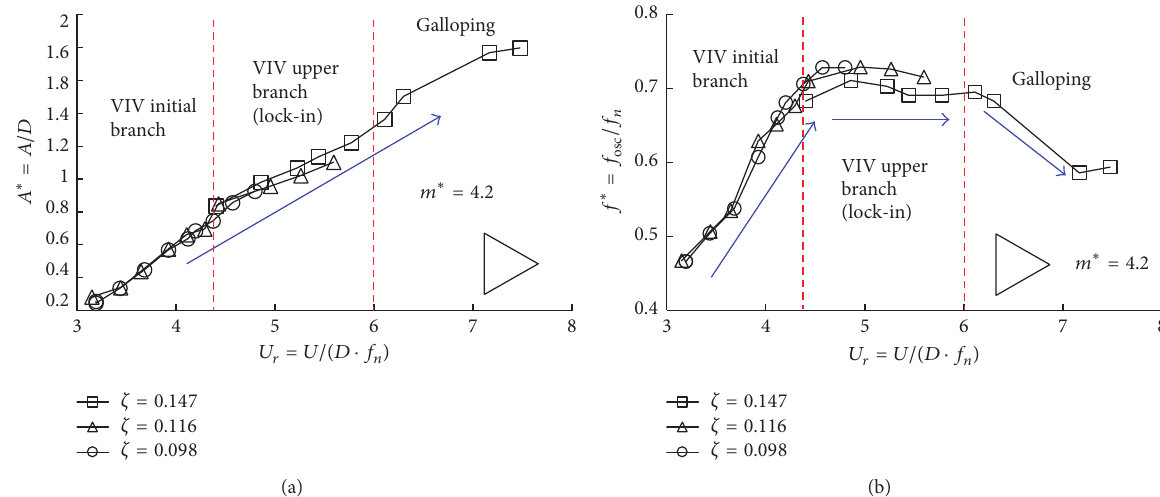
Figure 8: Variations of the amplitude ratios and the frequency ratios against the reduced velocities for regular triangle prism. Amplitude ratio 𝐴 ∗ = 𝐴/𝐷 ; frequency ratio 𝑓 ∗ = 𝑓 osc /𝑓 𝑛 ; reduced velocity 𝑈 𝑟 = 𝑈/(𝑓 𝑛 𝐷) ; damping ratios 𝜁 = 𝑐/2√𝑚 osc 𝐾 ; mass ratios 𝑚 ∗ = 𝑚 osc /𝑚 𝑑 ; 𝑚 ∗ = 4.2 ; (b) the responses of frequency ratios, 𝑚 ∗ = 4.2 . 𝑓 𝑛 is the natural frequency. (a) The responses of amplitude ratios,